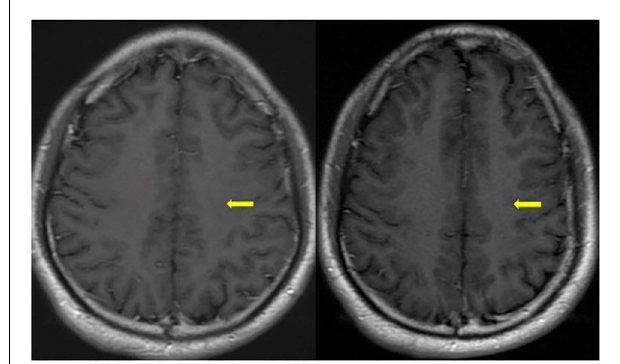
TABLE 3 | Recommendation on treatment in MOGAD